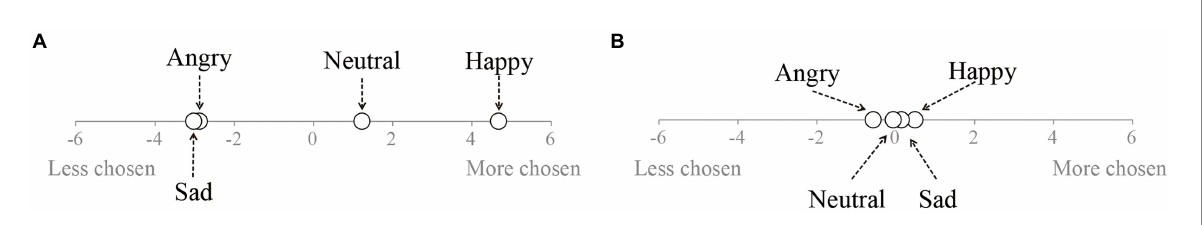
FIGURE 4 Results of experiment 3: Who is more attractive? Mean of the grade on the scale in attractiveness judgments with 500 ms presentation (A) and 5 s presentation (B)